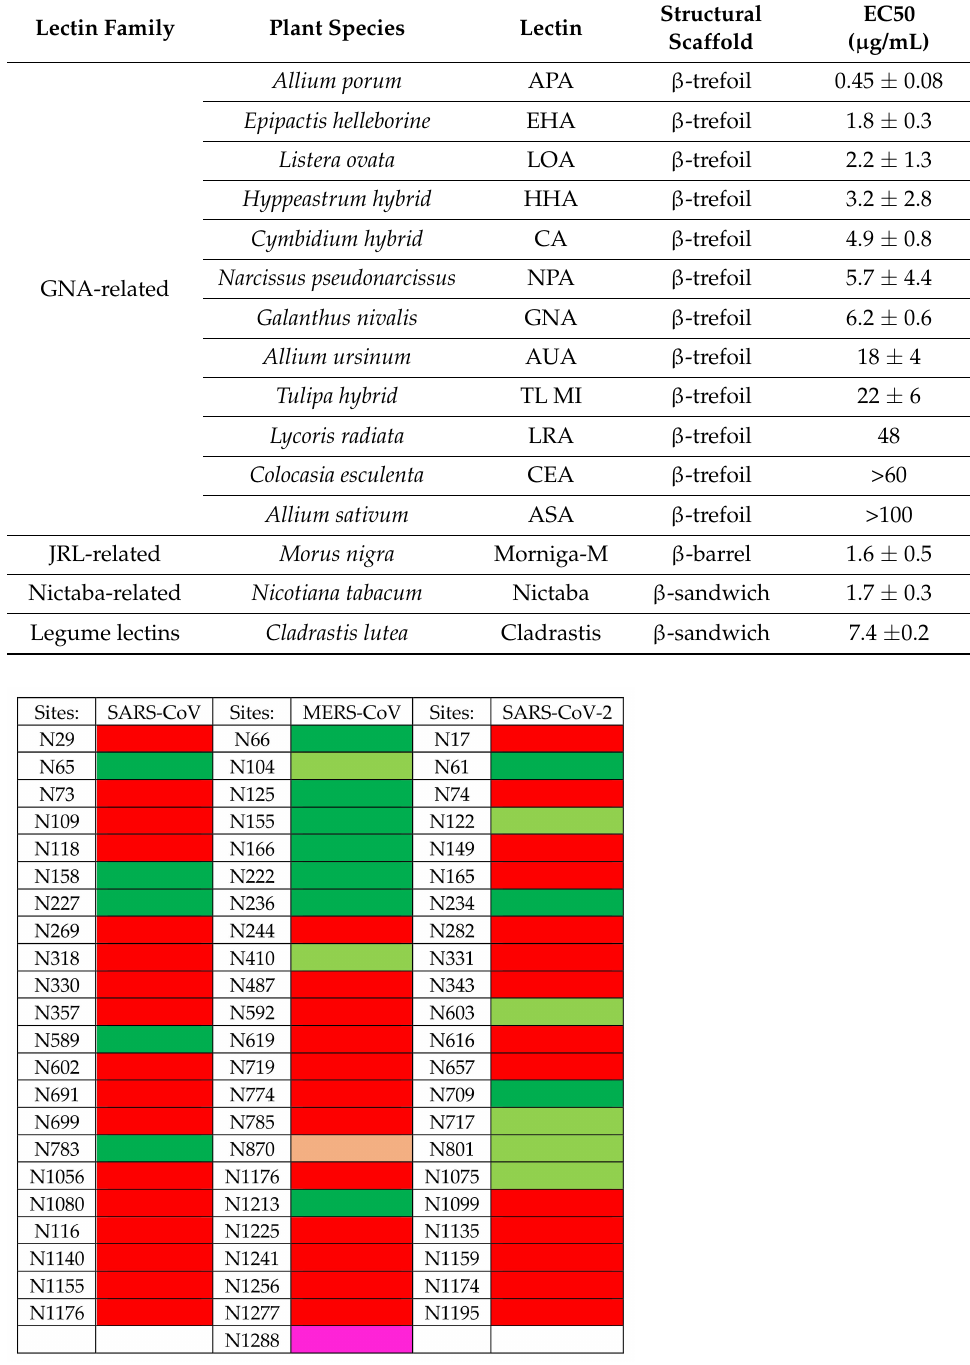
Table 1. Overview of Man-specific lectins from higher plants investigated in [13], for their anti-SARS- CoV activity, classified in decreasing order of activity (EC50 ( µ g/mL)). Adapted from [13].